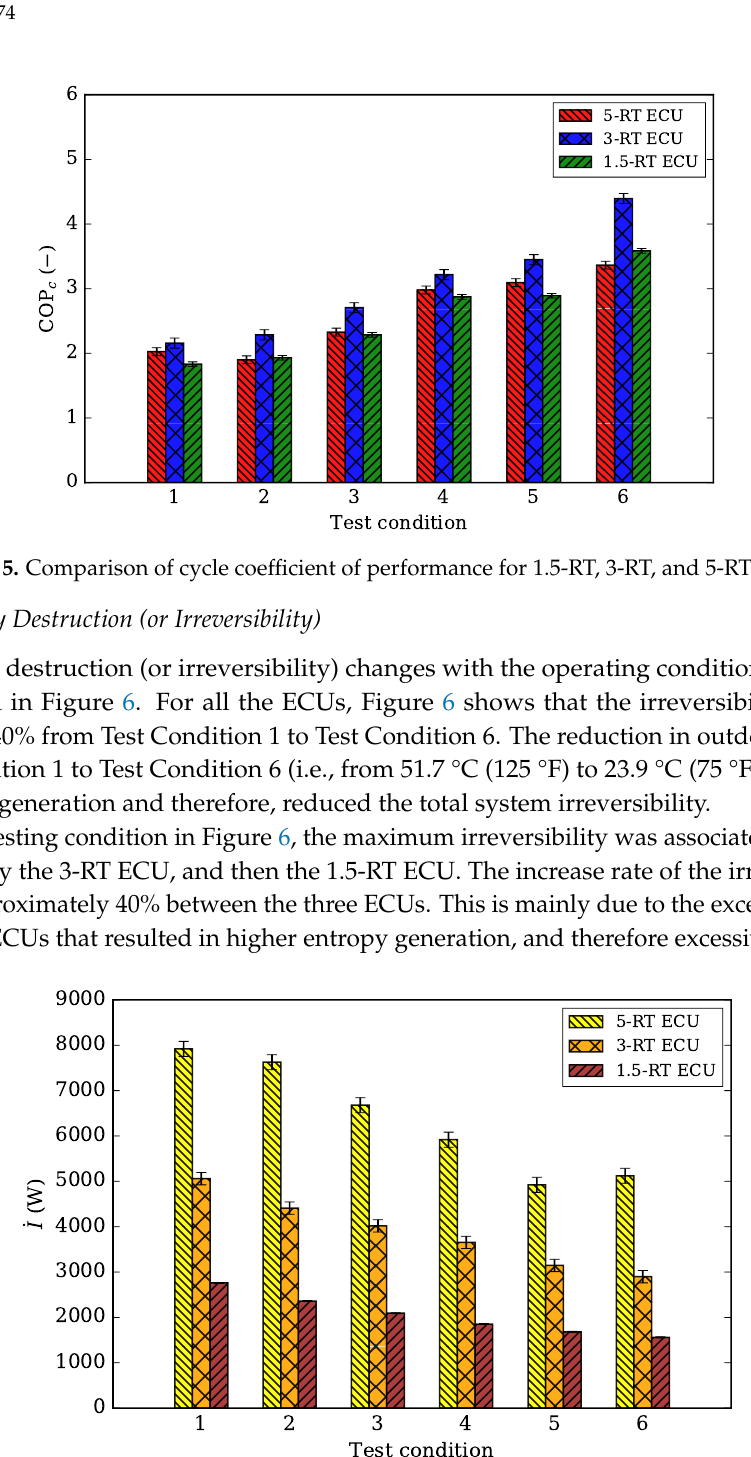
Figure 6. Comparison of exergy destruction (or irreversibility) for 1.5-RT, 3-RT, and 5-RT